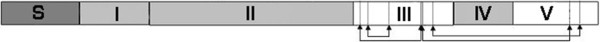
Schematic overview of the structure of gamma-gliadins. The proteins consist of a short N-terminal signal peptide (S) followed by a unique N-terminal domain (I) and a repetitive domain (II). Domain III contains most (often 6) of the cysteines. IV is rich in glutamine. Two conserved cysteines are in V. Eight cysteine residues (indicated with vertical lines) can form four interchain disulfide bonds (indicated as connections between lines). Figure after
[9].